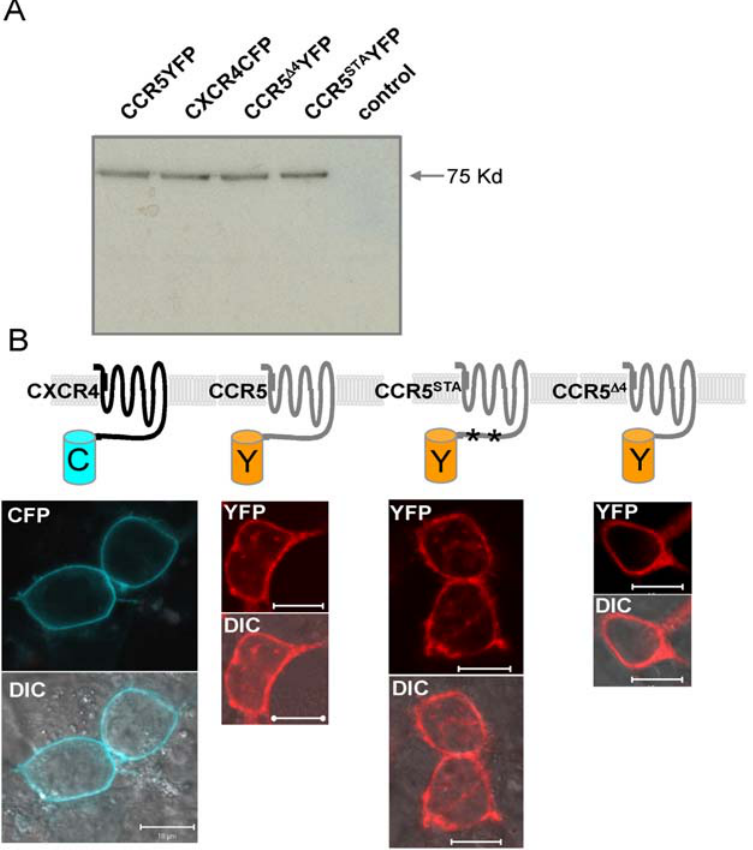
Figure 1. Expression of CXCR4 or CCR5 and CCR5 mutant receptors tagged with fluorescent proteins. A. The indicated CFP- or YFP- tagged receptors, transiently expressed in HEK293 cells, were detected in whole cell lysates by western blotting with an anti-GFP antibody. Untransfected HEK293 cells were included as a negative control. B. Schematic diagram of CXCR4CFP, CCR5YFP, CCR5 STA YFP and CCR4 D 4 YFP on the cell membrane. Confocal images of living cells expressing membrane-localized CXCR4CFP (cyan), CCR5YFP (red), CCR5 STA YFP (red) and CCR5 D 4 YFP (red); top panels, fluorescence images. Bottom panels, the merged images of the fluorescence and differential-interference-contrast (DIC) images. Scale bar, 10 m m.